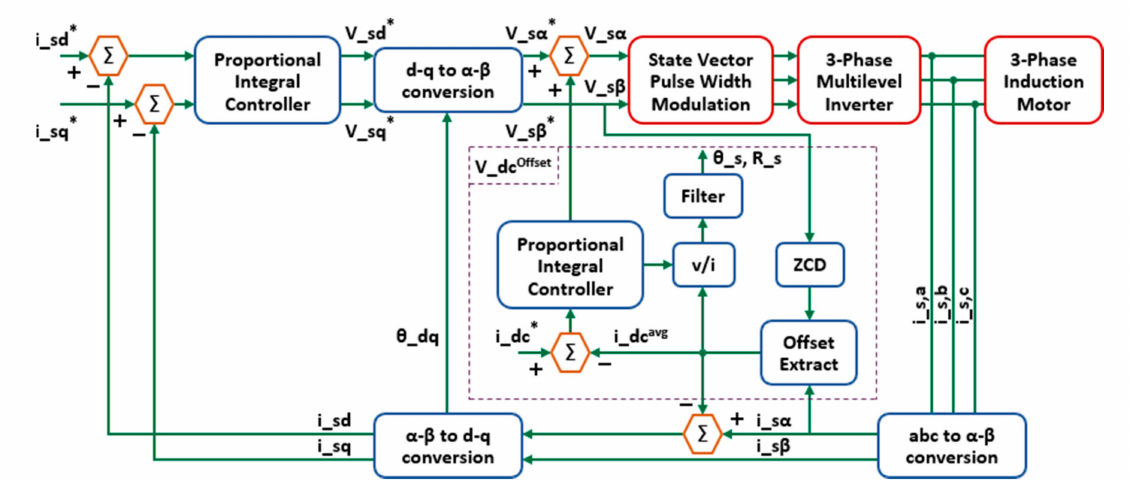
Figure 32. Block diagram for rotor flux linkage oriented control method of motor drive